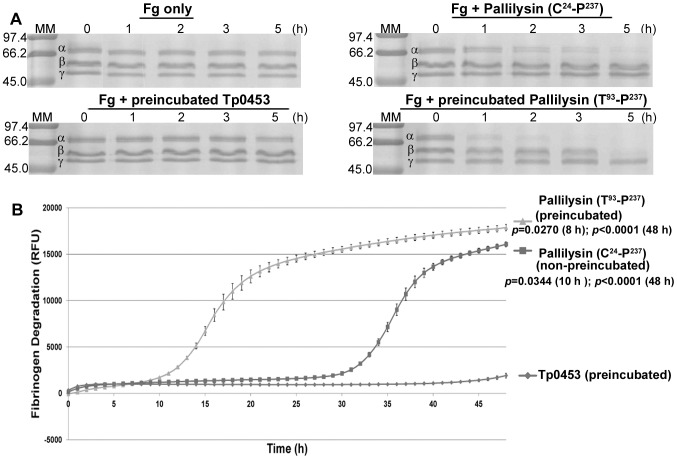
Autocatalysis enhances pallilysin-mediated fibrinogenolysis.(A) Wild-type pallilysin subjected to 22 h pre-incubation at 37°C (T93-P237) in the absence of substrate (30 µg) and non-pre-incubated wild-type pallilysin (C24-P237) (30 µg) were incubated with fibrinogen (60 µg) at 37°C for 5 h. Samples were removed at the times indicated and analyzed by SDS-PAGE to detect degradation of the fibrinogen α-, β-, and γ-chains. Negative controls included fibrinogen incubated in buffer alone (Fg only) and fibrinogen incubated in the presence of Tp0453, which had also been pre-incubated at 37°C for 22 h. Each lane contains approximately 6 µg of fibrinogen in the absence of proteolysis. Numbers to the left of the lanes indicate the size (kDa) of the corresponding molecular mass (MM) markers. (B) FITC-labelled fibrinogen (10 µg) was incubated at 37°C for 48 h in the dark with either non-pre-incubated wild-type pallilysin (C24-P237), pallilysin subjected to 22 h pre-incubation at 37°C (T93-P237) (1 µg), or the negative control Tp0453 (pre-incubated at 37°C for 22 h) (1 µg). The degree of fibrinogen degradation was measured every hour by detecting the increase in Relative Fluorescence Units (RFU) over 48 h using standard fluorescein excitation/emission filters. Average fluorescence intensity readings from octuplicate measurements are presented with bars indicating standard error (SE), and the results are representative of three independent experiments. For statistical analyses, fibrinogen degradation by wild-type pallilysin (non-pre-incubated [C24-P237] and pre-incubated [T93-P237]) was compared to that of Tp0453 (pre-incubated) using the Student's two-tailed t test. Pre-incubated (T93-P237) and non-pre-incubated (C24-P237) wild-type pallilysin exhibited a statistically significant level of fibrinogenolysis at 8 h (p = 0.0270) and 10 h (p = 0.0344) post-incubation, respectively, and beyond, compared to the level of fibrinogen degradation exhibited by the negative control, Tp0453.